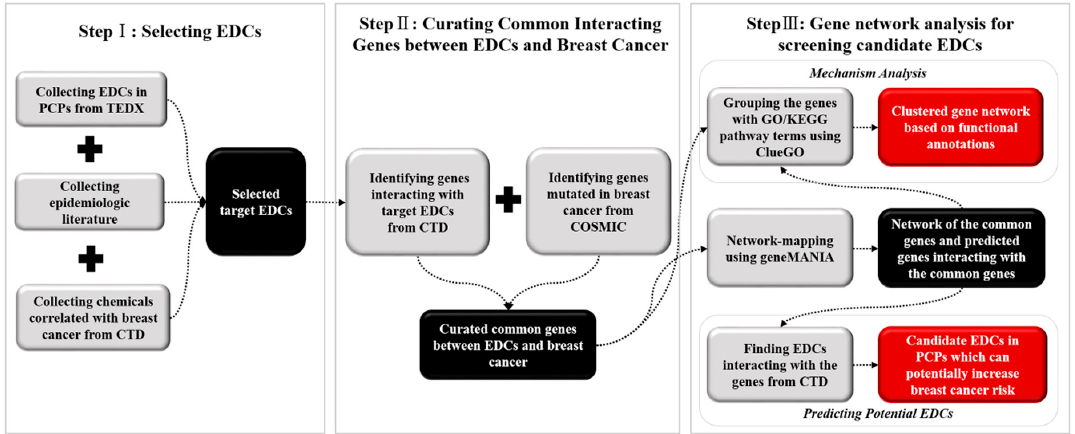
Figure 1. Scheme of this study including the data integration combined with gene network analysis to identify associations between endocrine disrupting chemicals (EDCs) and breast cancer. Notes: TEDX—